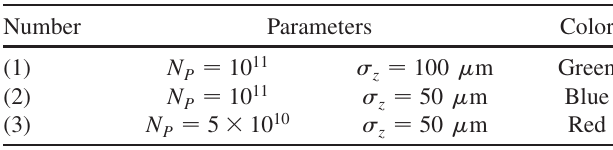
TABLE II. Parameters of fixed-shape